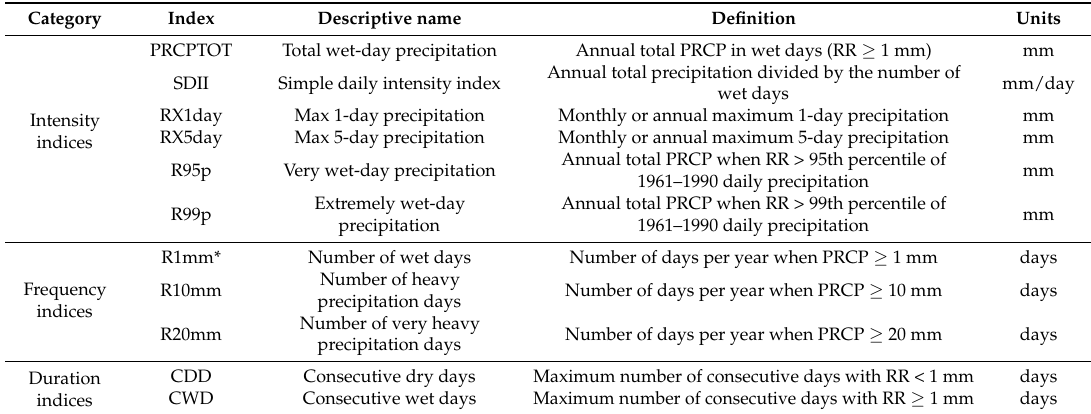
Table 2. Extreme precipitation indices used in this